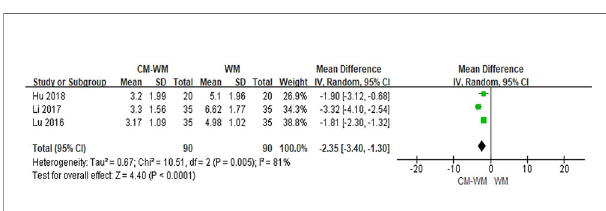
FIGURE 6 | Meta-analyses on VAS.